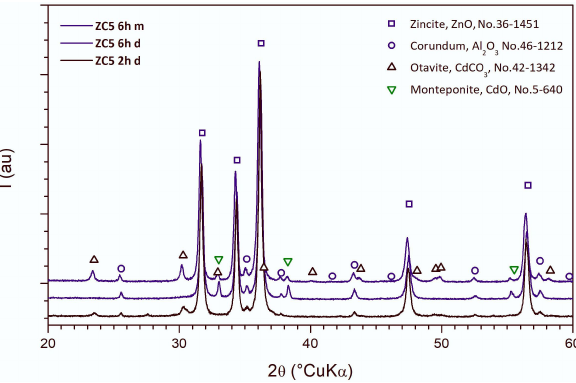
Figure 2: XRD patterns of samples with 5% of Cd milled for 2 h and 6 h, thermally treated at 600 ∘ C and analysed after 1 day (d) and 1 month